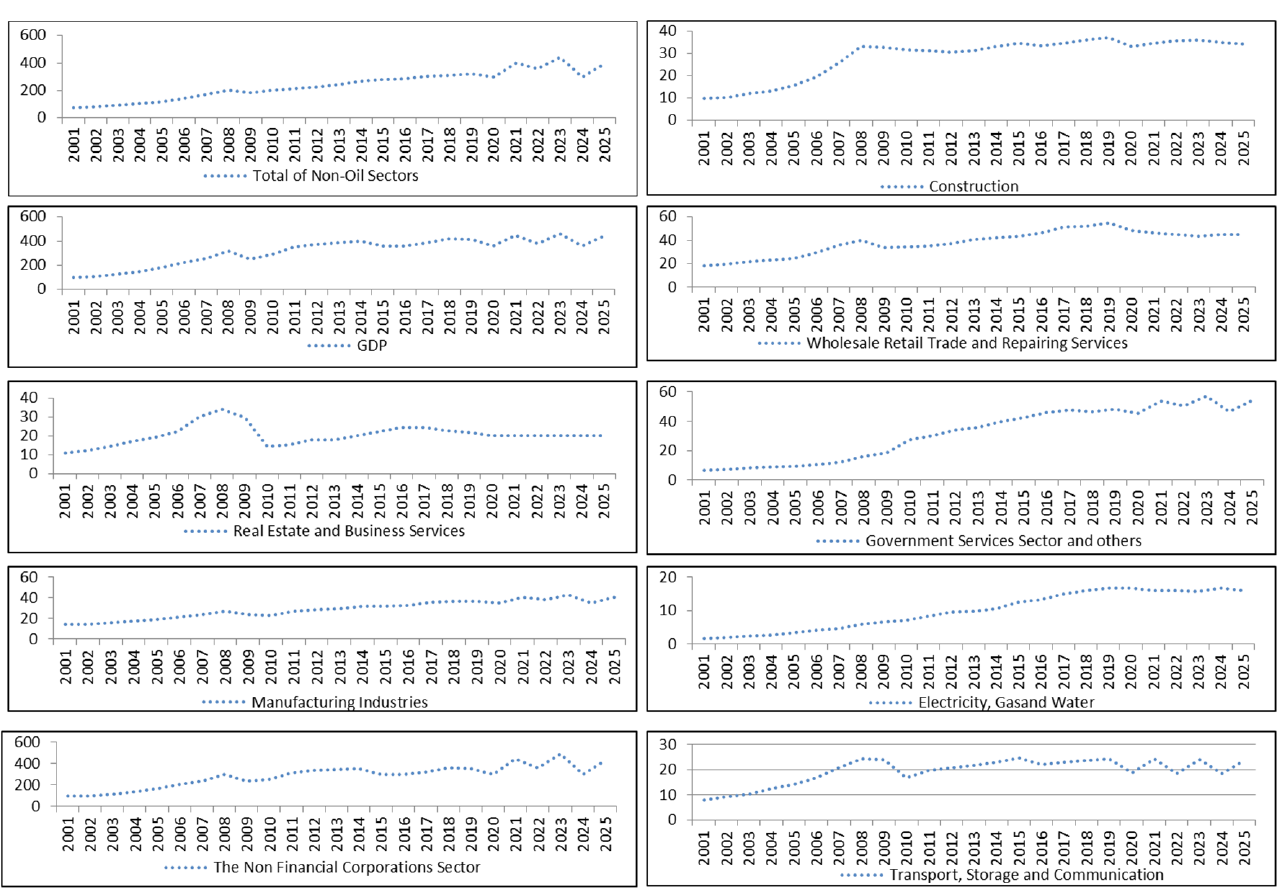
Figure 8. Forecasting results of the UAE macroeconomic (independent) variables, dependent variable mining and quarrying (including crude oil and natural